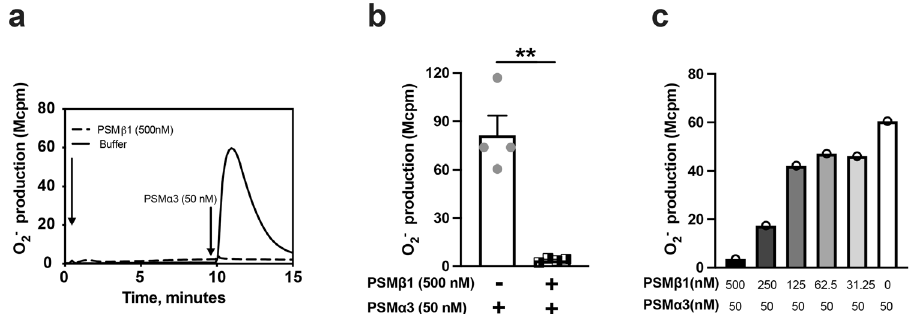
Fig. 2 The PSM α 3 induced activation of the neutrophil NADPH-oxidase is inhibited by PSM β 1. a NADPH oxidase-induced superoxide anion release (O 2 − , y -axis) by neutrophils was measured by isoluminol-ampli fi ed chemiluminescence over time (min, x -axis). The cells were preincubated at 37 °C for 5 min before being fi rst challenged with one agonist (arrow to the left) and then with a second agonist PSM α 3 (50 nM, arrow to the right) once the fi rst response had returned to baseline. Shown is one representative trace out of four individual experiments for neutrophils fi rst stimulated with PSM β 1 (500 nM) or buffer (control) and then PSM α 3 (50 nM). b The peaks O 2 − release by neutrophils stimulated with PSM β 1 (500 nM) or buffer control followed by PSM α 3 (50 nM) were compared. c The representative bar graphs show the peak O 2 − release from the neutrophils fi rst stimulated with different concentrations of PSM β 1 (500 nM, 250 nM, 125 nM, 62.5 nM, 31.25 nM, 0 nM), and then challenged with PSM α 3 (50 nM). The experiment was performed 3 times with different buffy coats. All experiments showed the similar pattern. Statistical comparison was done using paired t test, with data expressed as mean ± standard error of the mean b . ** P <